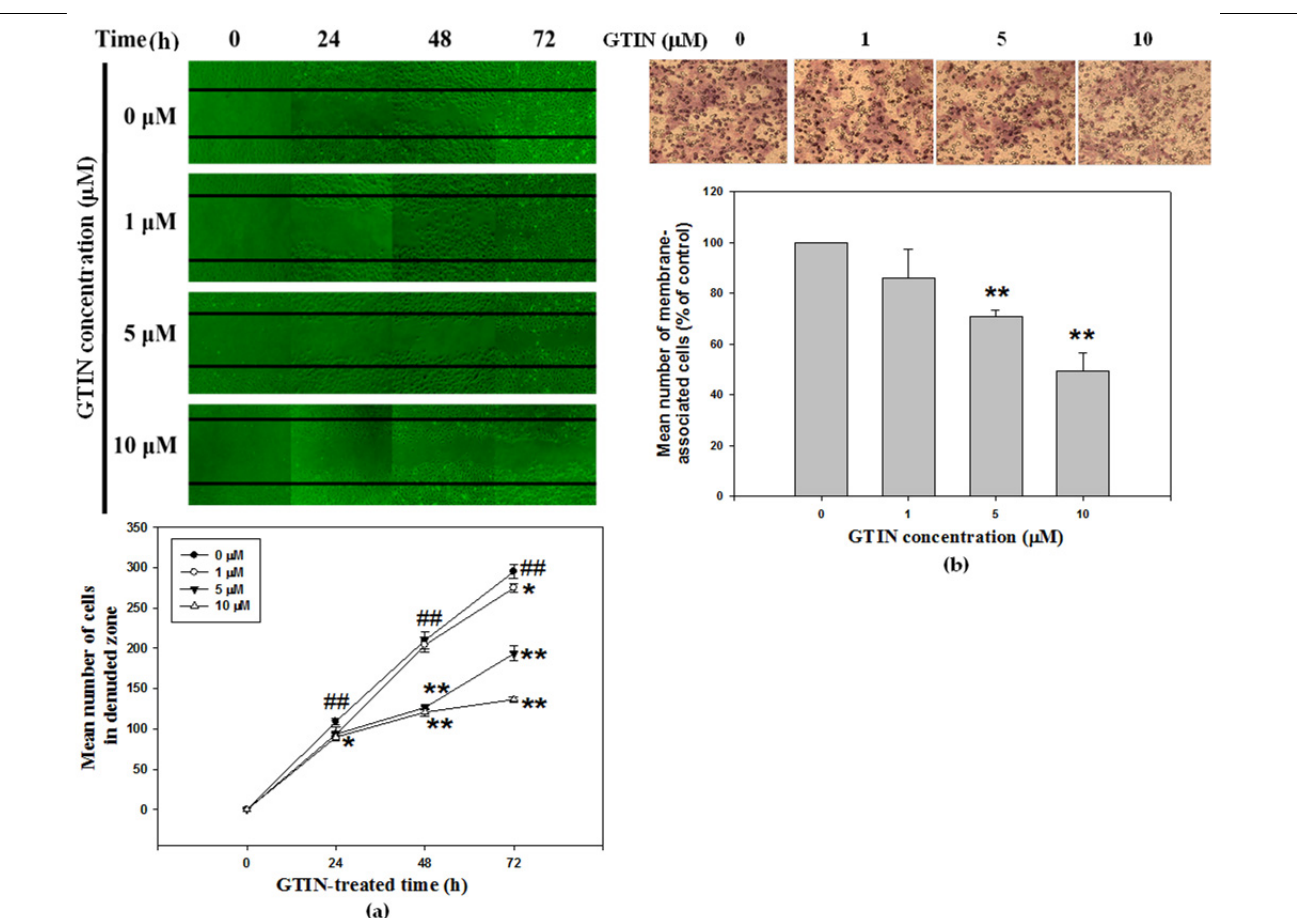
Figure 3. GTIN inhibited wound-healing and cell migration in VSMCs. ( a ) Monolayers of growth-arrested A7r5 cells treated with GTIN at the indicated doses (0, 1, 5 and 10 µ M) were wound, and the cell numbers in the denuded zone were photographed and quantified for 0, 24, 48 and 72 h. The result was showed as mean ± SD of three repeats from at least three independent experiments. ## p < 0.01 compared with the 0-h untreated control via one-way ANOVA with Dunnett’s post-hoc analysis. * p < 0.05, ** p < 0.01 compared with the respective time point of the untreated control via one-way ANOVA with Dunnett’s post-hoc analysis. ( b ) A7r5 cells were treated with GTIN at the indicated doses (0, 1, 5 and 10 µ M) for 48 h. The treated cells were subjected to assay for Transwell migration method. Images of the membrane-associated cells (purple parts) were then analyzed by Giemsa stain. The result was showed as mean ± SD of three repeats from at least three independent experiments. * p < 0.05, ** p < 0.01 compared with the untreated control via one-way ANOVA with Dunnett’s post-hoc analysis.